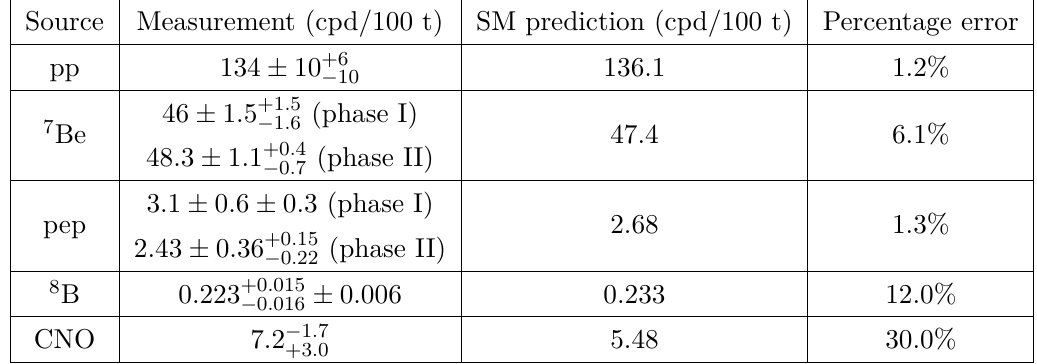
Table 1 . The measured event rates at Borexino and our predicted event rates in the SM. The theoretical percentage uncertainties are given in the last